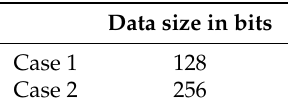
Table 6. Communication-cost comparison criteria.